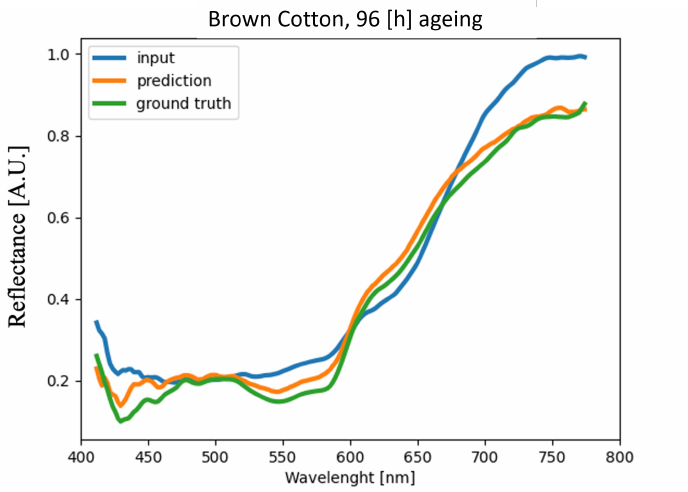
Figure 18. Averaged blood spectra comparison for the sample on white cotton fabric substrate and acquired at time t = 96 h.